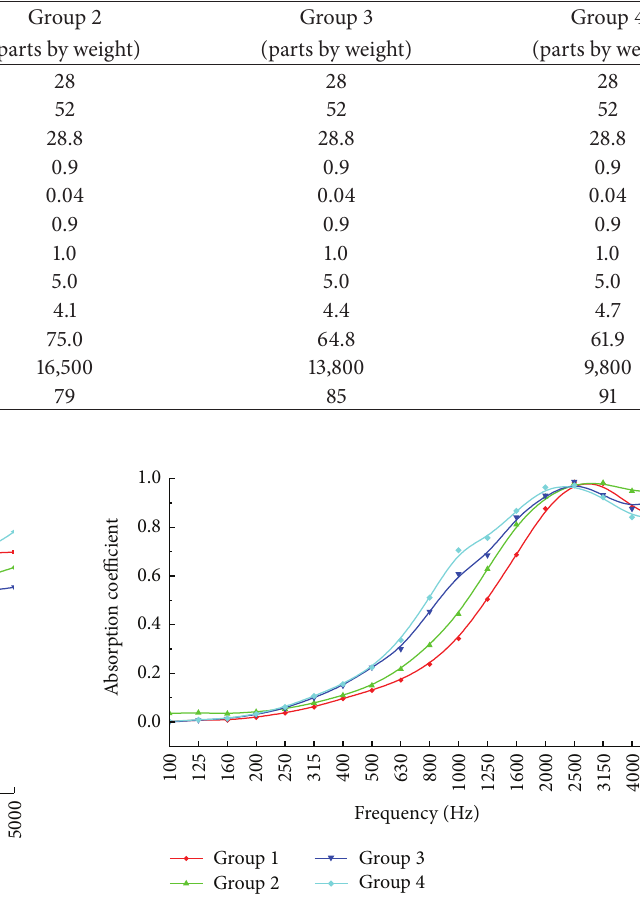
Figure 9: Curves of the sound absorption character of the PU foams with varying water with the 141b. (a) Group 1 with water 3.8 parts by weight, (b) Group 2 with water 4.1 parts by weight, (c) Group 3 with water 4.4 parts by weight, and (d) Group 4 with water 4.7 parts by